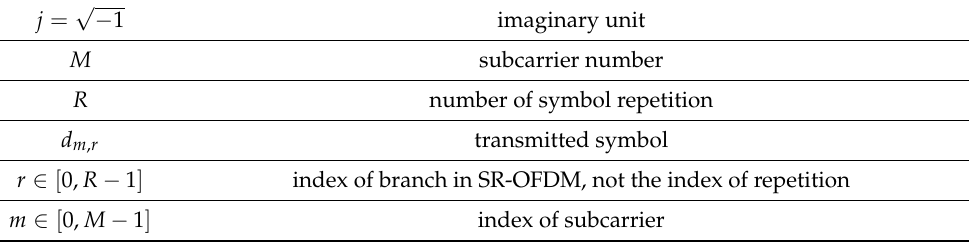
Table 1. Some notations in this